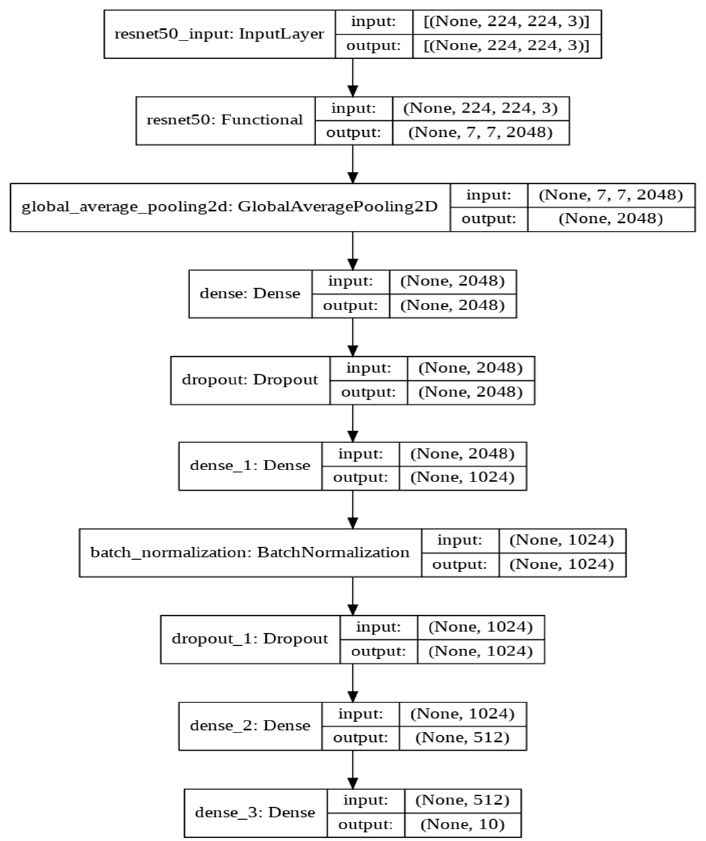
Figure 6. ResNet50 Architecture. VGG16 Model : The VGG16 model (Figure 7) is among the largest models with many parameters. The padding is 1 pixel for 3 × 3 convolutional layers to preserve the